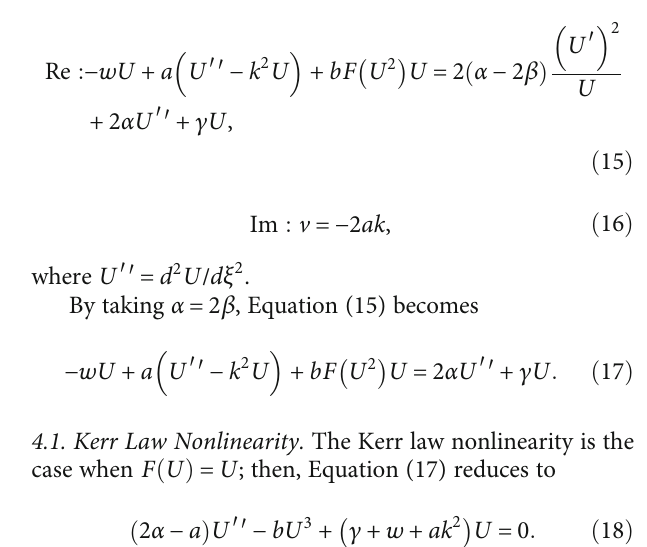
ffiffiffiffiffiffiffiffiffiffiffiffiffiffiffiffiffiffiffiffiffiffiffiffiffiffiffiffiffi p ffiffiffiffiffiffiffiffiffiffiffiffiffiffiffiffiffiffiffiffiffiffiffiffiffiffiffiffiffi 4 AC − 4 C − B 2